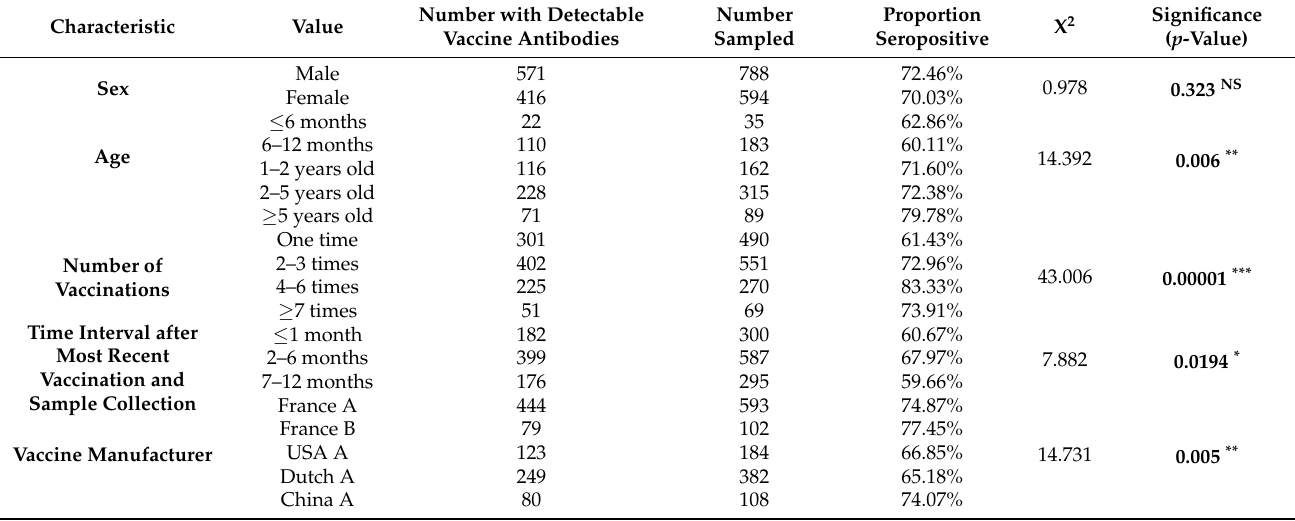
Table 4. Potential factors associated with seroconversion in dogs.